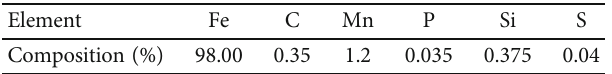
Table 1: Chemical composition of A515 Grade 70 carbon steel